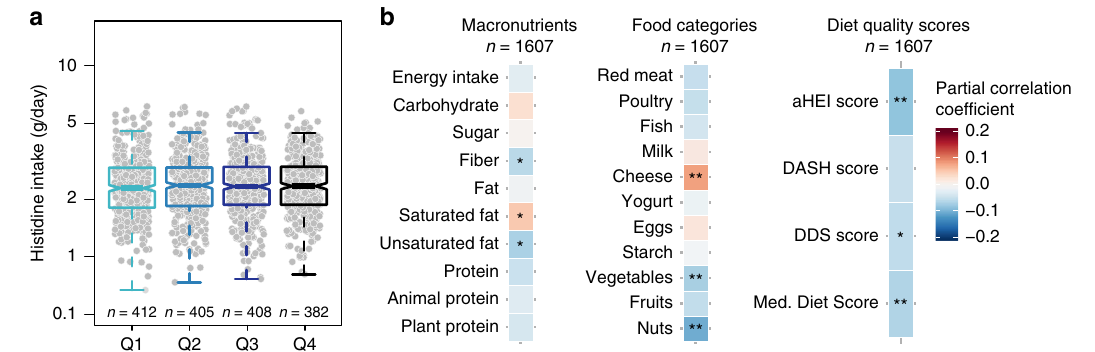
Fig. 3 Imidazole propionate is associated with an unhealthy diet, but not histidine intake. a Dietary histidine intake according to quartiles of imidazole propionate. P- values were calculated with linear regression adjusted for age, gender, body mass index, ethnicity, diabetes status, creatinine clearance, daily energy intake (kcal/day), and enrollment center. Data are represented as boxplots: middle line is the median, the lower and upper hinges are the fi rst and third quartiles, the upper whisker extends from the hinge to the largest value no further than 1.5× the interquartile range (IQR) from the hinge, and the lower whisker extends from the hinge to the smallest value at most 1.5× IQR of the hinge. Gray dots are single data points. b Correlation matrix for imidazole propionate serum levels and macronutrients, food categories and dietary scores [the alternate Healthy Eating Index (aHEI), Dietary Approaches to Stop Hypertension (DASH) score, dietary diversity score (DDS) and Mediterranean diet score]. Pearson partial correlation coef fi cients and P -values were calculated using partial correlations adjusted for age, gender, body mass index, ethnicity, diabetes status, creatinine clearance, daily energy intake (kcal/day), and enrollment center. * P < 0.05, **False discovery rate (FDR) adjusted P < 0.05. See Supplementary Table 8. Source data are provided as a Source Data fi